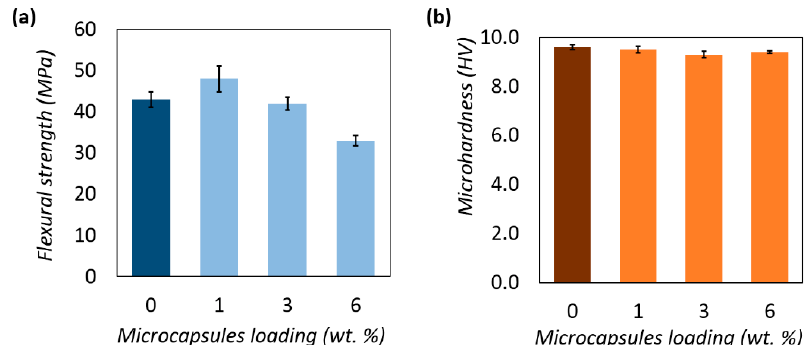
Figure 14. Effect of the microcapsules loading on the mechanical properties of the epoxy matrix: ( a ) Flexural strength; and ( b ) Microhardness (Vickers).